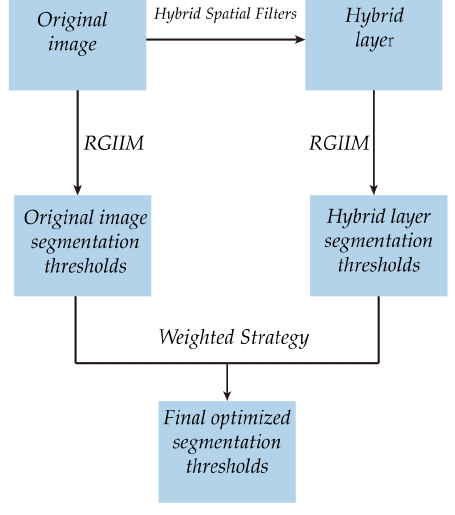
Figure 5. Framework of the proposed algorithm.